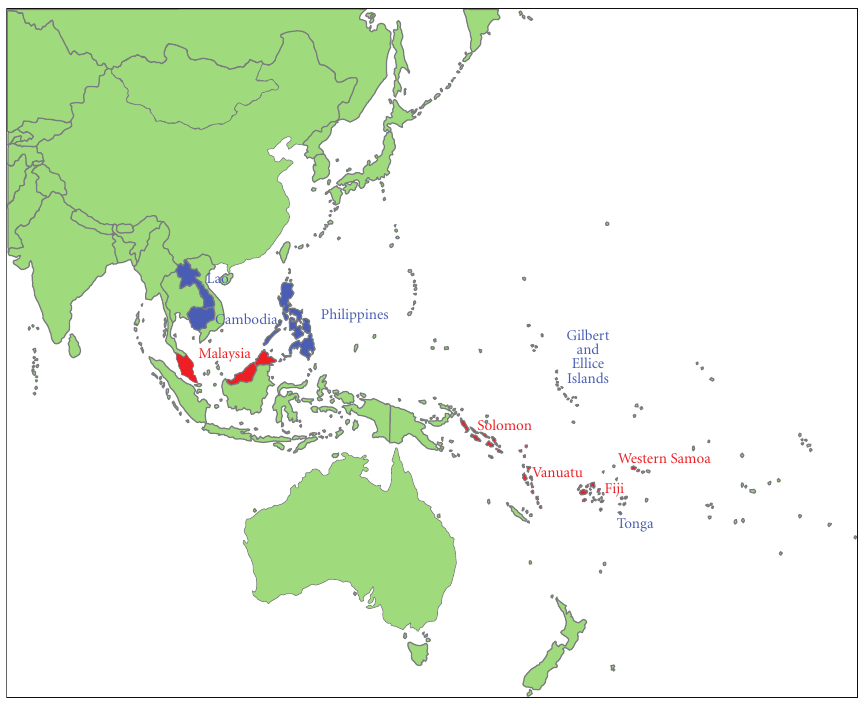
Figure 1: Yaws prevalence in the Western Pacific Region in the